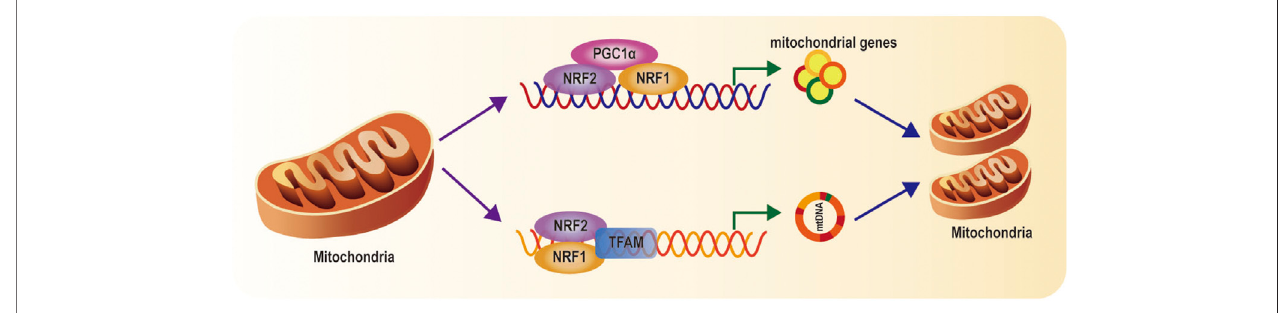
FIGURE 2 | Mitochondrial biogenesis pathways: When PGC-1 α is activated, PGC-1a activates NRF1 and NRF2, and subsequently TFAM, which regulate genes involved in subunits of mitochondrial respiratory chain complexes, import of nuclear-encoded mitochondrial proteins, and mtDNA replication and